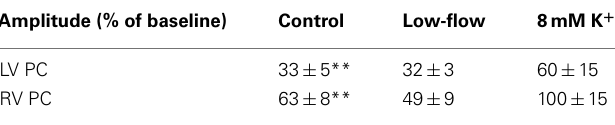
Table 1 | Change in signal amplitude duringVF in LV and RV expressed as a percentage of the baseline amplitude.